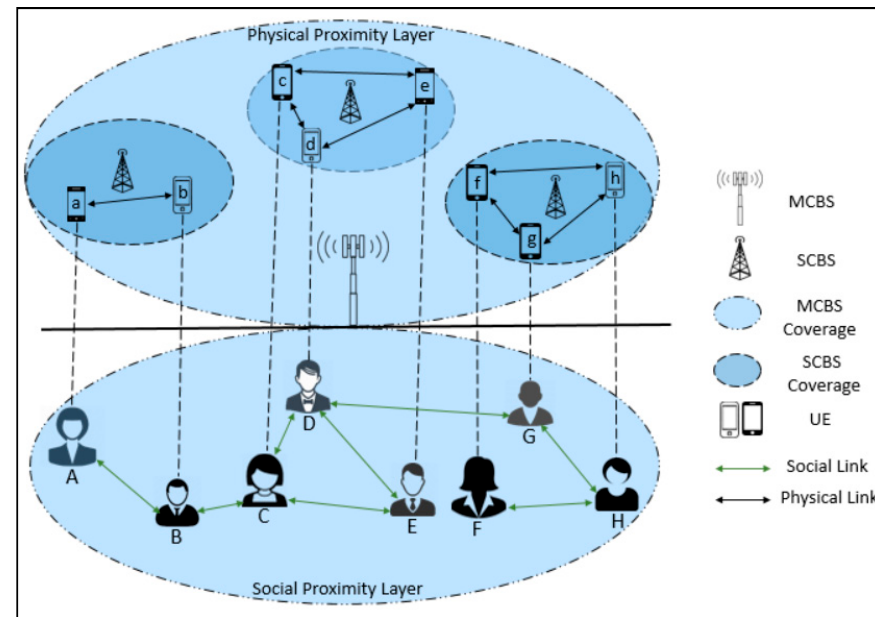
Figure 1. The D2D architecture with social and physical proximity layers.